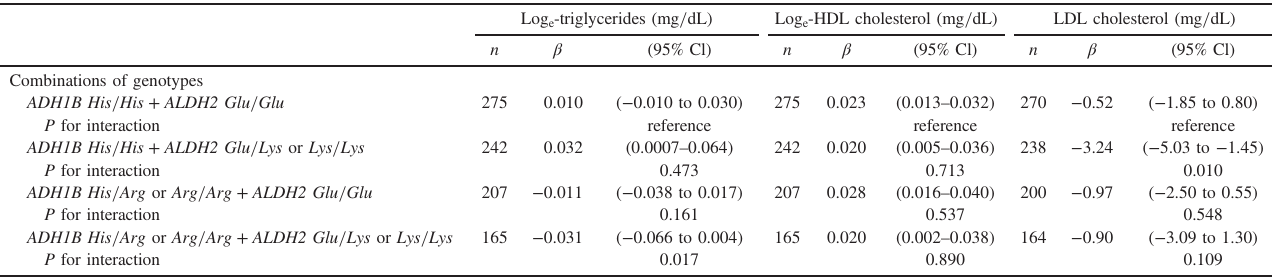
Table 4. Increase in serum lipid levels with an increase of alcohol intake by 10g / day according to the combinations of ADH1B and ALDH2 genotypes in the main study a Log e -triglycerides (mg = dL) Log e -HDL cholesterol (mg = dL) Combinations of genotypes ADH1B His = His + ALDH2 Glu =